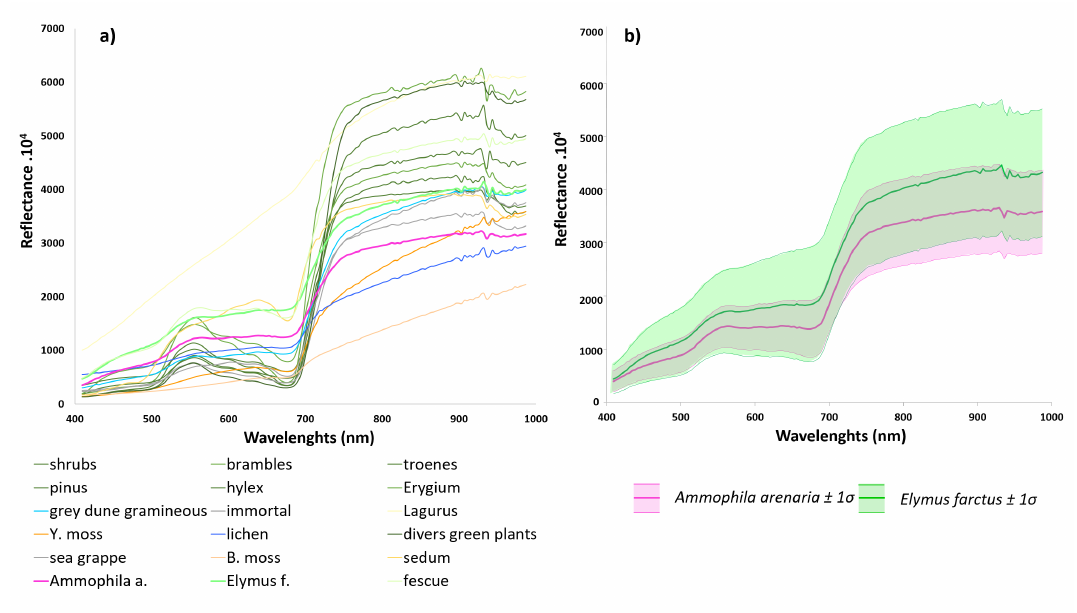
Figure 4. Dune vegetation spectral range. ( a ) Represents the field-acquired mean spectrum of the 17 main plants of the scene; ( b ) represents mean spectra ( thick lines ) plus or minus one standard deviation ( colored areas ) for Ammophila arenaria ( green ) and Elymus farctus ( pink ). This shows that the major part of their spectral variation ranges overlaps, making a multi-temporal systematic discrimination based on a spectral argument almost